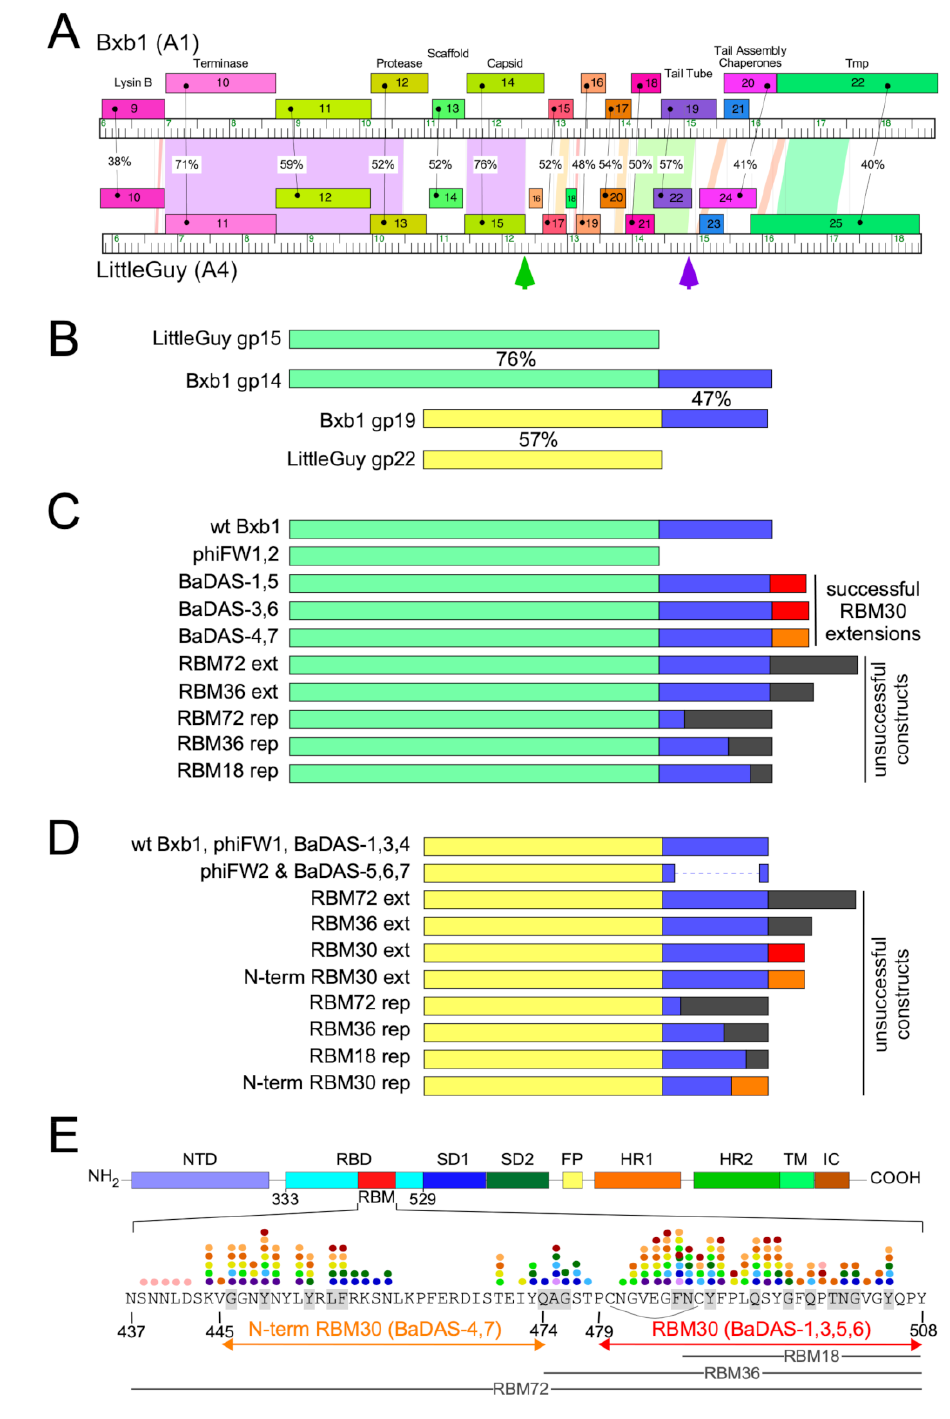
Figure 1. Design of Bacteriophage Displaying Antigens of SARS-CoV-2 (BaDAS) recombinant phages. ( A ) Alignment of phage Bxb1 (Subcluster A1) and LittleGuy (Cluster A4) virion structural genes. Genomes are represented as horizontal tracks with the predicted rightwards-transcribed genes